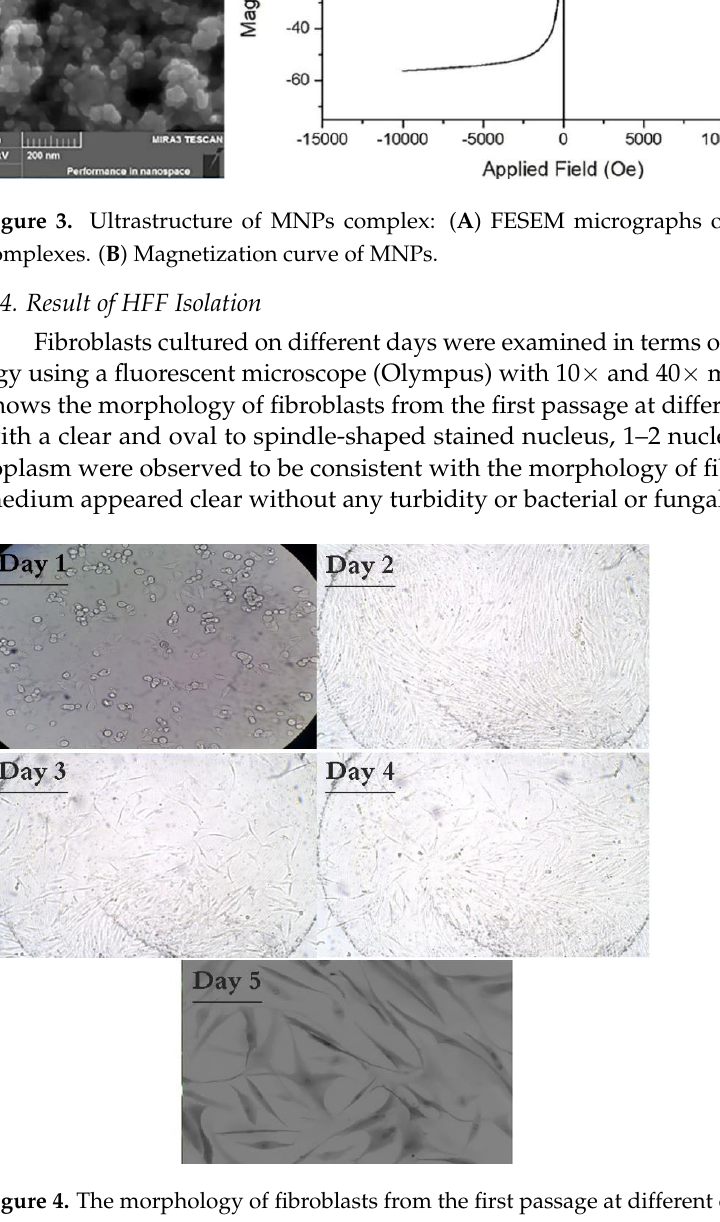
Figure 3. Ultrastructure of MNPs complex: ( A ) FESEM micrographs of magnetic-nucleic acid complexes. ( B ) Magnetization curve of MNPs.